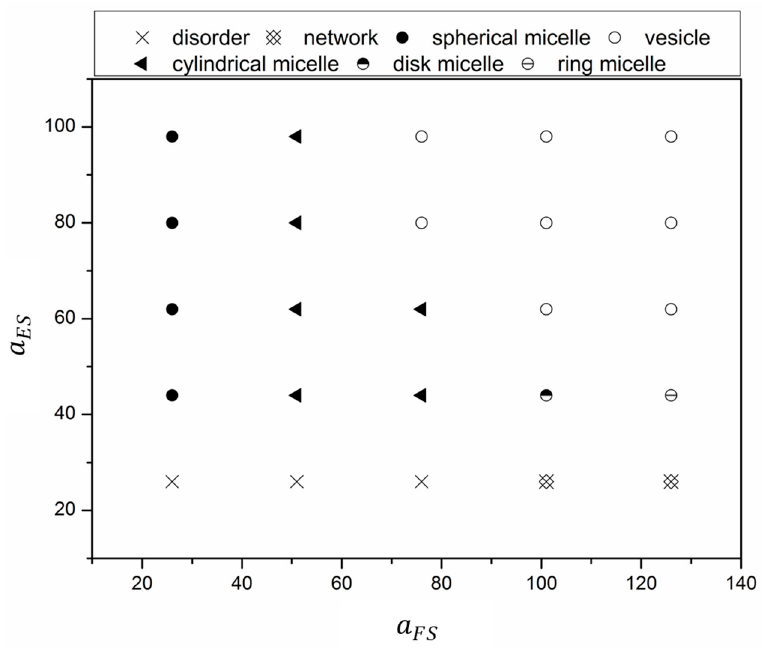
Figure 2. Effect of solvophobicity of longest E block and shortest F block on the equilibrium mor- phologies.